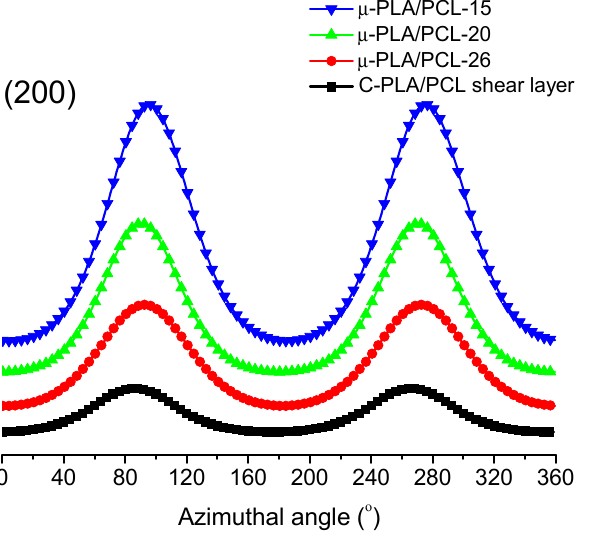
Figure 7. The (200) azimuthal intensity profiles of dispersed phase polycaprolactone (PCL) in microparts with different cavity size and shear layer of macropart.